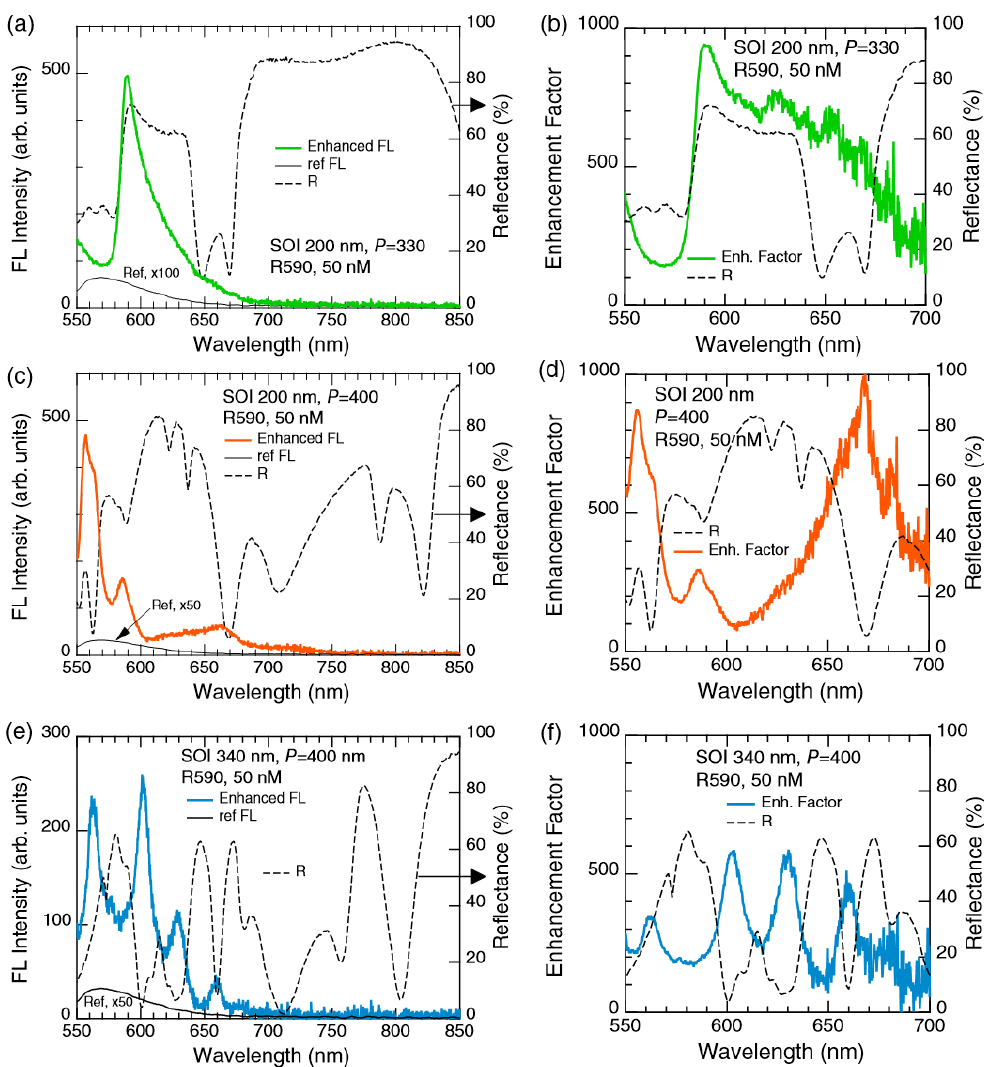
Figure 3. A series of measured enhanced fluorescence (FL) (colored curves) and R spectra (black dashed curves). The FL comes from the R590 molecules dispersed on the SOI–rod metasurfaces. ( a ) A set of FL (green curve) and R (black dashed curve) spectra on a metasurface of a SOI of 200 nm thickness and P = 330 nm. ( b ) FL-intensity enhancement factor in ( a ) is shown with a green curve. ( c ) A set of FL (orange curve) and R (black dashed curve) spectra on a metasurface of a SOI of 200 nm thickness and P = 400 nm. ( d ) FL-intensity enhancement factor in ( c ) is represented by an orange curve. ( e ) A set of FL (blue curve) and R (black dashed curve) spectra on a metasurface of a SOI of 340 nm thickness and P = 400 nm. ( f ) FL-intensity enhancement factor in ( e ) is shown with a blue curve. Note that the reference FL spectrum is shown with a black curve in ( a , c , e ), and that the R spectra in ( a , c , e ) are plotted for the right axes. The definition of the enhancement factor is described in the text.